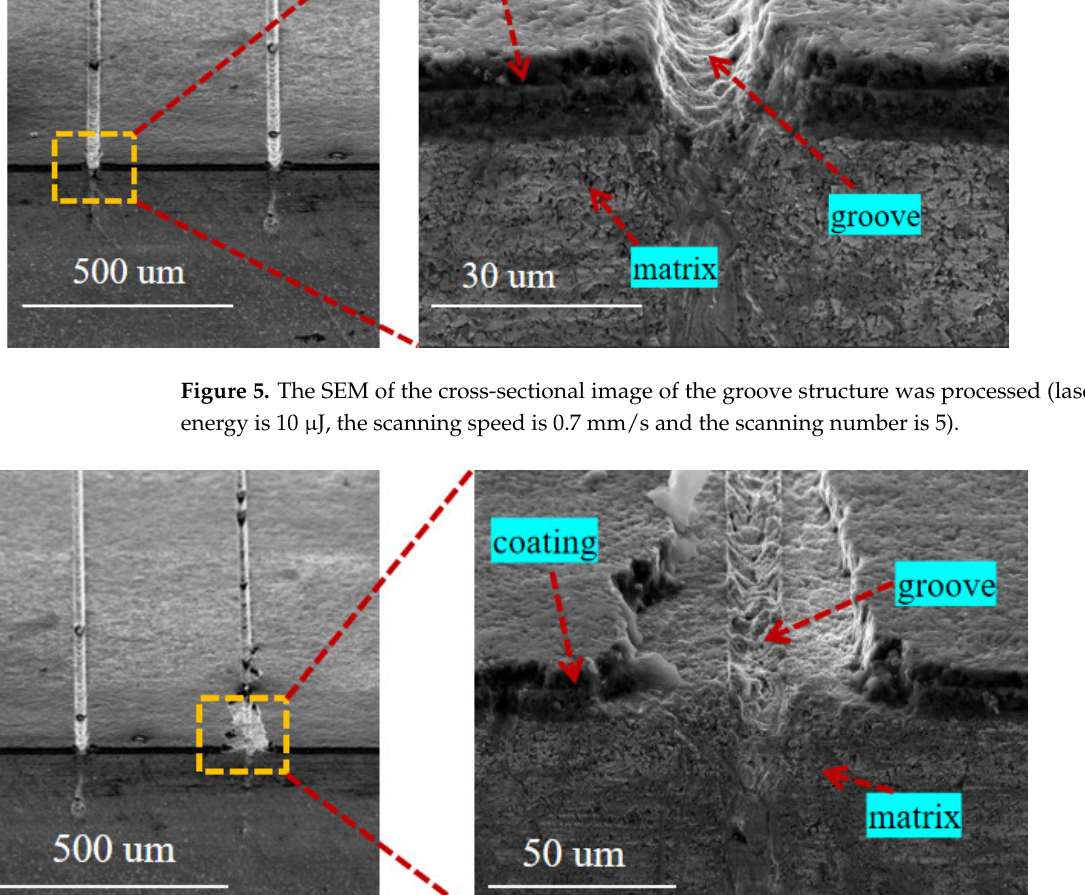
Table 4. The range of the femtosecond laser processing parameters.